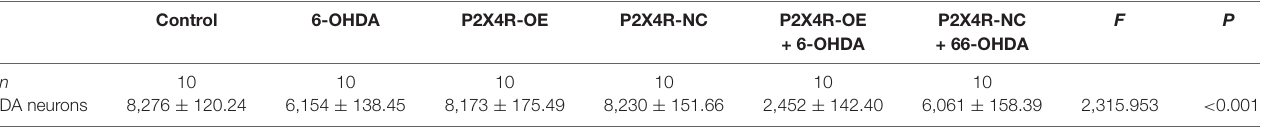
TABLE 3 | The number of tyrosine hydroxylase (TH) positive DA neurons in the SN of rats.